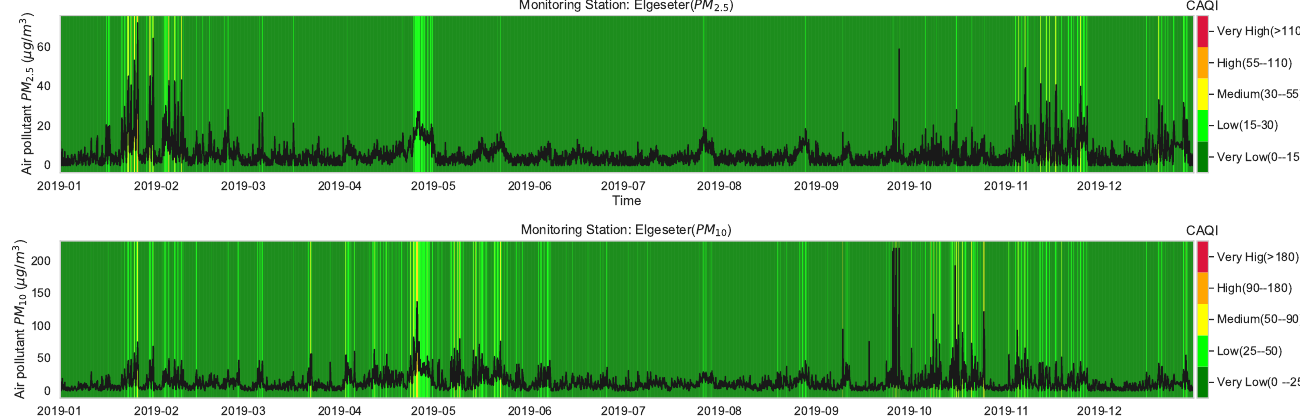
Figure 3. Air quality level over one year of one representative monitoring station in Trondheim, where the air pollutant is commonly at a Very Low level and rarely exceeds Low